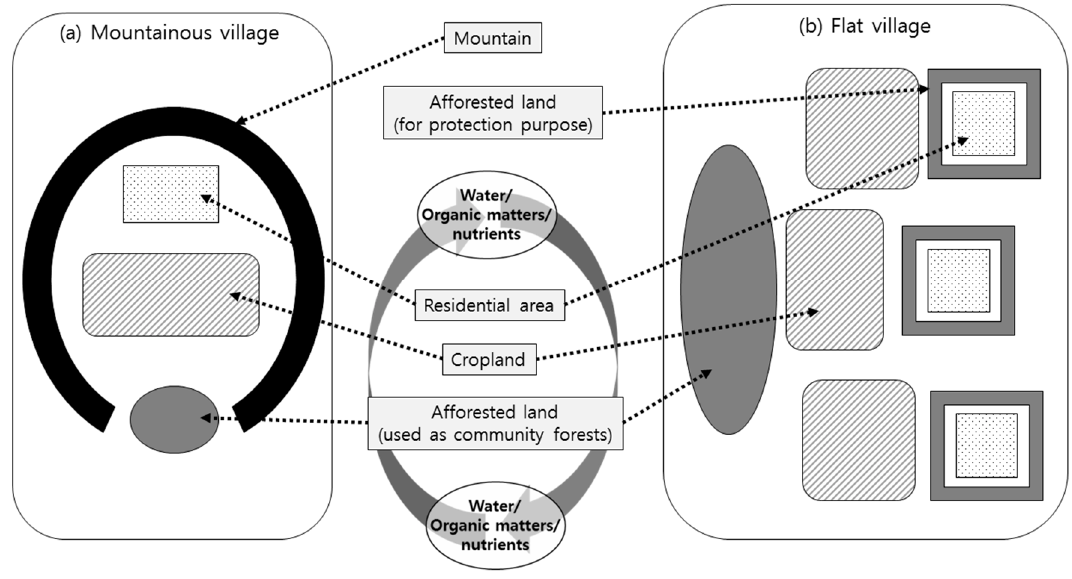
Figure 1. Types of the traditional community forests based on Fengshui in Northeast Asia (modification of the conceptual figures in [4,30]).